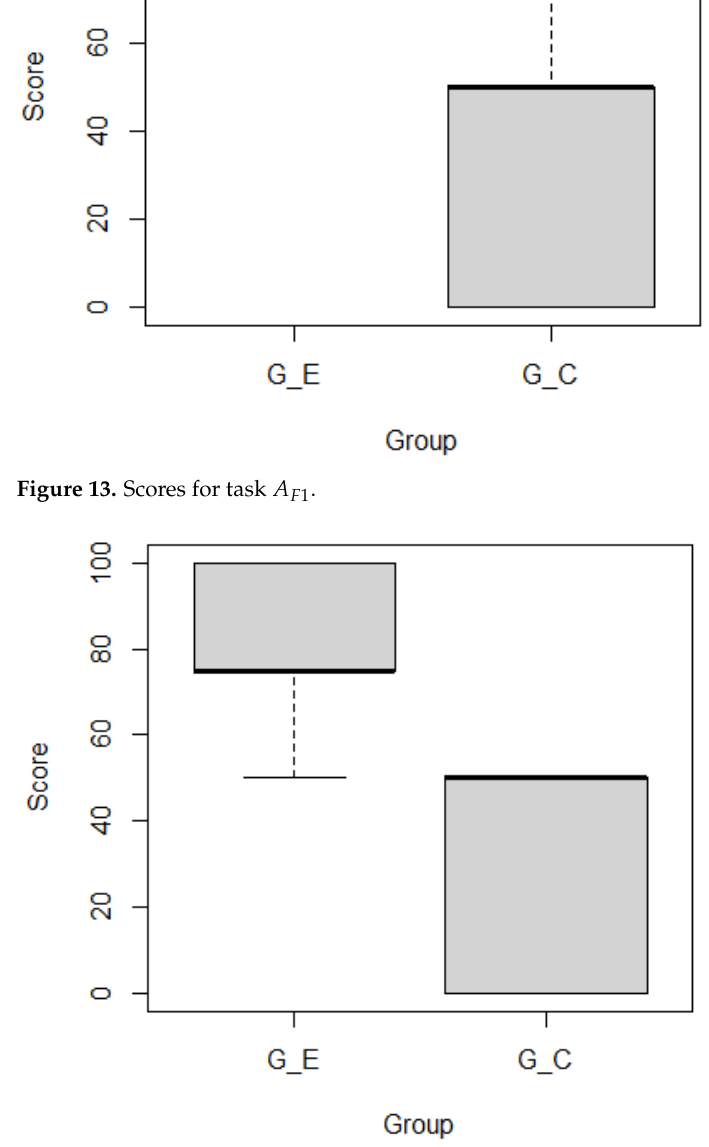
Figure 14. Scores for task A F 2